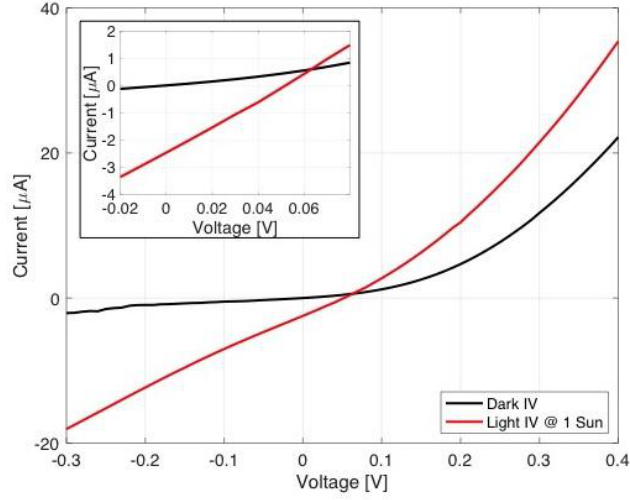
Figure 12. Current-voltage response of FS-1P7L specimen is shown under one-sun light and without light. The inset provides a clear view of the short circuit current and open circuit voltage from the vertical axis intercept and the horizontal axis intercept.